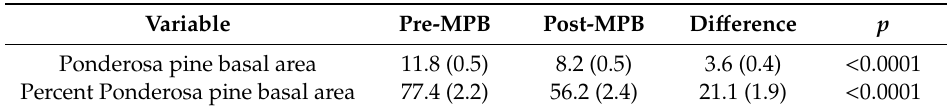
Table 1. Mean (SE) Pinus ponderosa basal area (m 2 / ha) and the percentage of pre- and post-